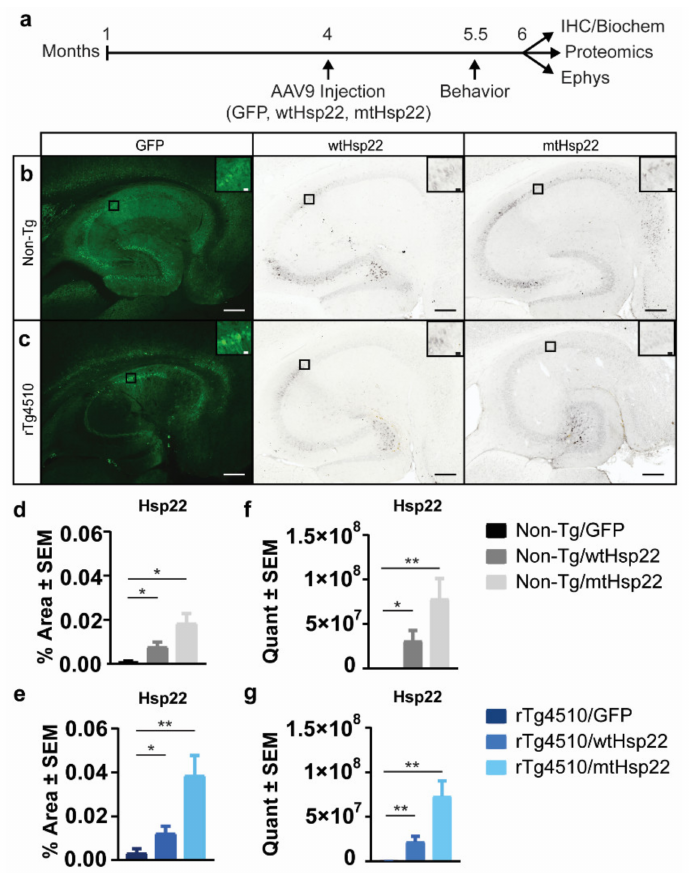
Figure 1. Hsp22 levels were significantly upregulated by AAV9. ( a ) Timeline of in vivo study. ( b ) Representative images of GFP, wtHsp22, and mtHsp22 levels in non-transgenic (Non-Tg) mice. ( c ) Representative images of GFP, wtHsp22, and mtHsp22 levels in rTg4510 mice. Scale bar represents 200 µ m; inset represents 20 µ m. ( d ) Quantification of immunohistochemical staining of Hsp22 levels in non-Tg mice (mean ± SEM, * p < 0.05) and ( e ) rTg4510 mice (mean ± SEM, * p < 0.05, ** p < 0.01) GFP ( n = 5/Non-Tg; n = 7/rTg4510), wtHsp22 ( n = 7/Non-Tg; n = 6/rTg4510) mtHsp22 ( n = 6/Non- Tg; n = 6/rTg4510). ( f ) Quantification of Hsp22 levels in non-Tg mice by parallel reaction monitoring (mean ± SEM, * p < 0.05, ** p < 0.01). ( g ) Quantification of Hsp22 levels in rTg4510 mice by quantitative mass spectrometry parallel reaction monitoring (mean ± SEM, ** p < 0.05). GFP ( n = 6/Non-Tg; n = 6/rTg4510), wtHsp22 ( n = 7/Non-Tg; n = 6/rTg4510) mtHsp22 ( n = 6/Non-Tg; n = 6/rTg4510). Table 1. Summary of mice used for AAV9